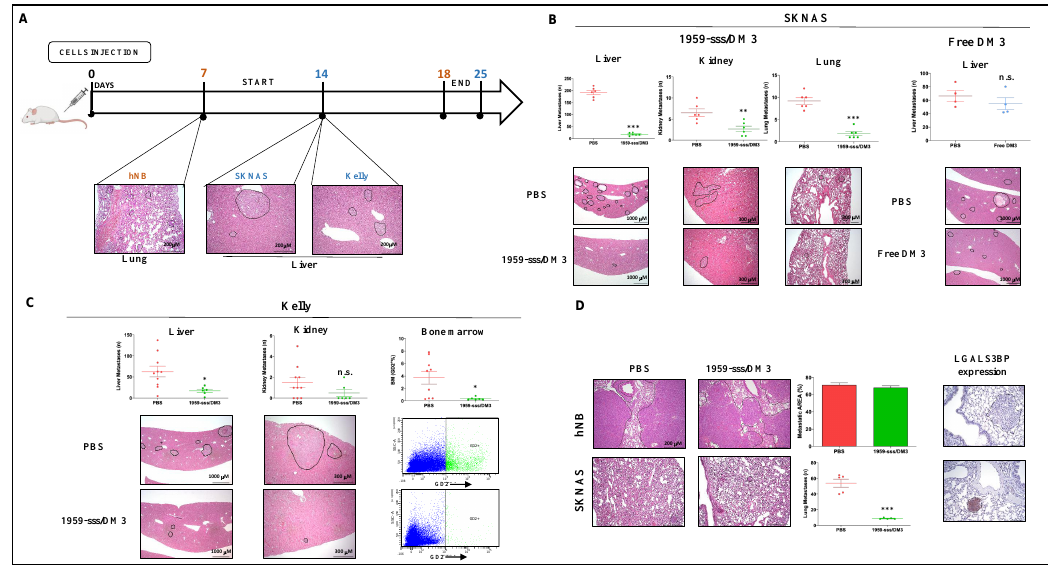
Figure 5. Targeting LGALS3BP by 1959-sss / DM3 inhibits metastatic spreading. ( A ) Schematic representation of experimental metastasis assays performed in SKNAS ( B ), Kelly ( C ) and hNB ( D ) neuroblastoma cell models. PBS, 1959-sss / DM3 (10 mg / kg), or free SH-DM3 (0.1 mg / kg) intravenous injections were performed every three days for a total of 3 doses. Metastatic lesions were analyzed and plotted on graphs as number of lesions (SKNAS and Kelly) or as percentage of metastatic area (hNB). Representative images of H&E staining are shown below. Bone marrow metastasis ( C ) were analyzed by FACS analysis and plotted on graphs as percentage of GD2 + cells. Representative dot plots are shown below. Expression of LGALS3BP on lung metastatic lesions was evaluated by IHC staining ( D ). Unpaired T Test. * p = 0.01; ** p = 0.006; *** p < 0.0001. n.s. (not